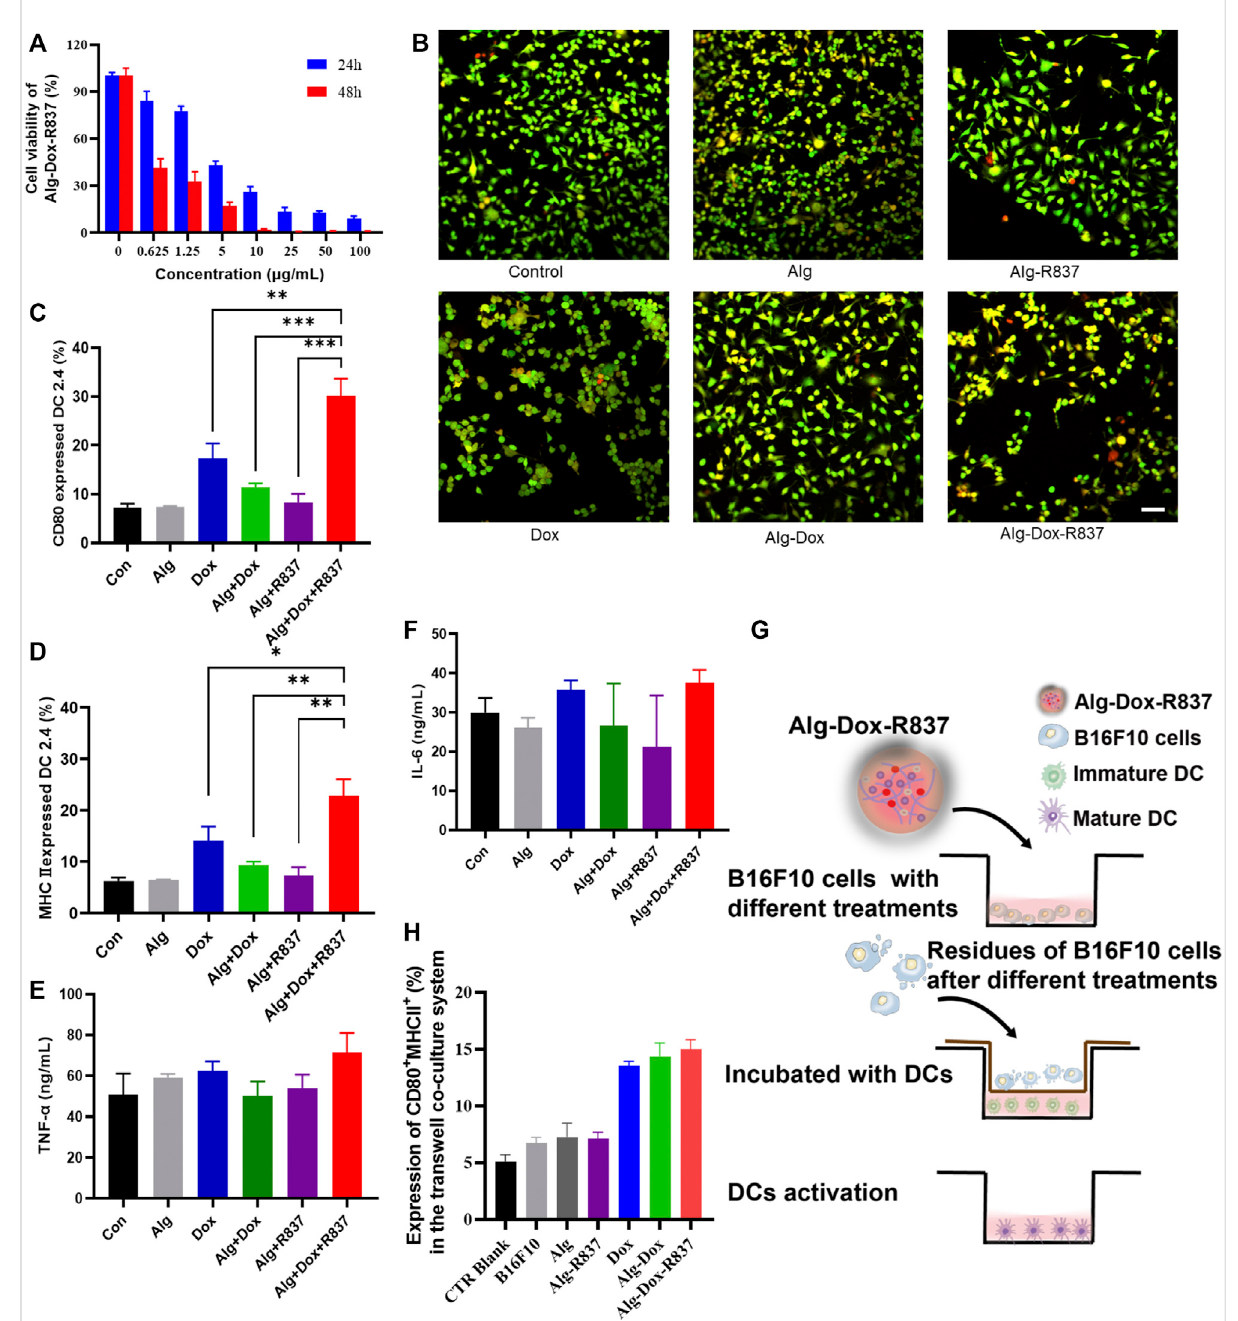
FIGURE 3 In vitro cell killing and activation of dendritic cells (A) Killing effect of Alg-Dox-R837 on B16F10; (B) Fluorescence images of dead and live cells after different treatments obtained by calcein AM and PI staining (scale bar: 70 μ m); (C,D) The expression of DC surface markers CD80 and MHCII was assessed by fl ow cytometry; (E,F) The secretion of TNF- α and IL-6 in the culture supernatant of DC was measured by ELISA; (G) Schematic